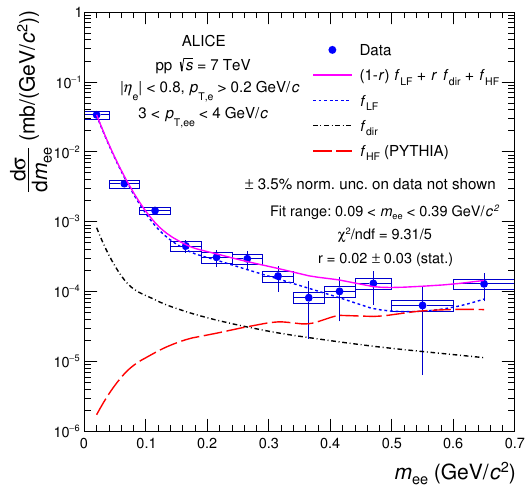
p s = 7 TeV in the ALICE acceptance